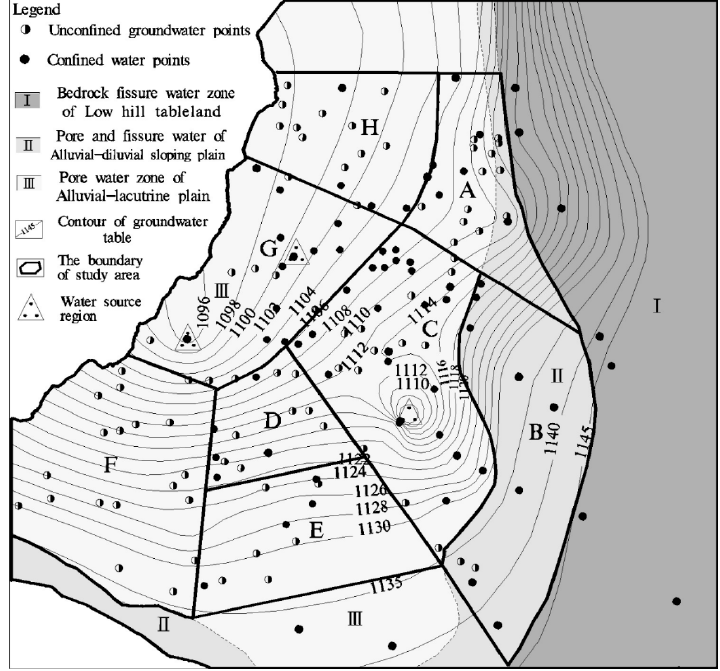
Figure 10. Cells in the confined aquifer and the distribution of the water chemistry sampling points.